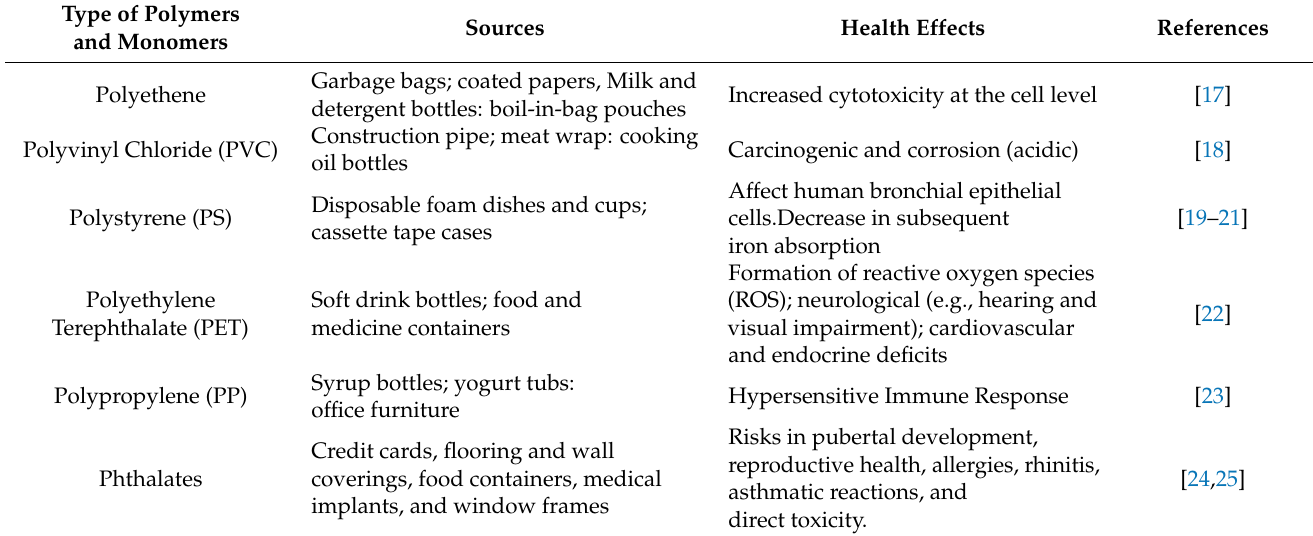
Table 1. Impact of plastic polymers and monomers on human